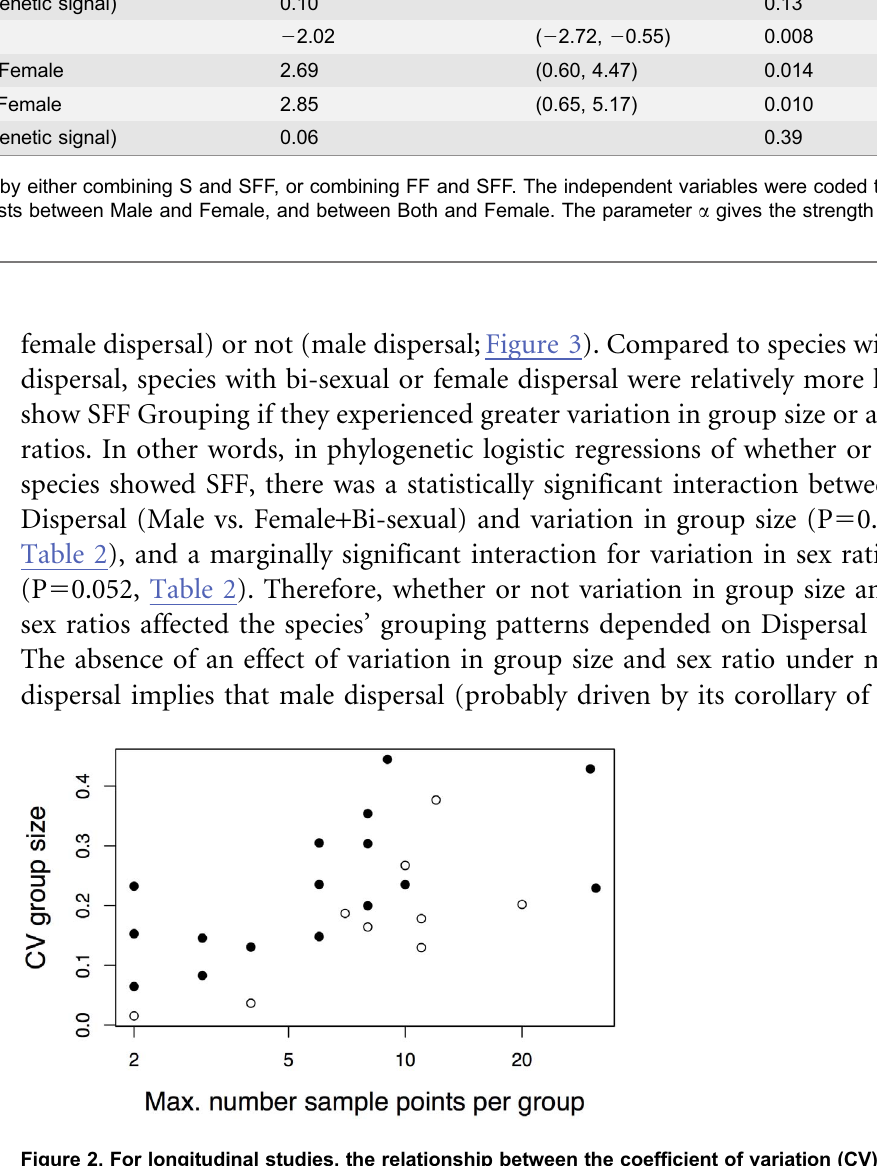
Figure 2. For longitudinal studies, the relationship between the coefficient of variation (CV) in Group size through time versus the maximum number of samples taken for any group within the study (note the log scale). For longitudinal group-level studies (solid circles) in which more than one group was followed through time, the CV was calculated as the mean CV in group size among groups, and the number of samples corresponds to the group with the greatest number of observations. For longitudinal population-level studies (open circles) the CV was calculated for the mean group size through time, and the number of samples equals the number of